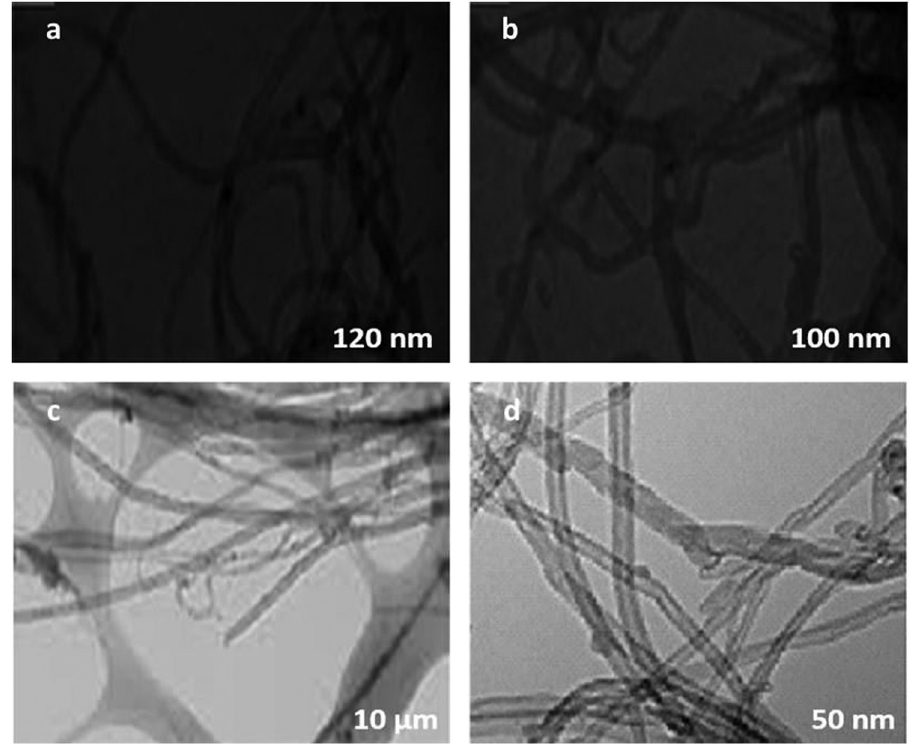
Figure 15: ( a – d ) TEM images of MWCNT powder ( courtesy: Nanoshel, USA ) .